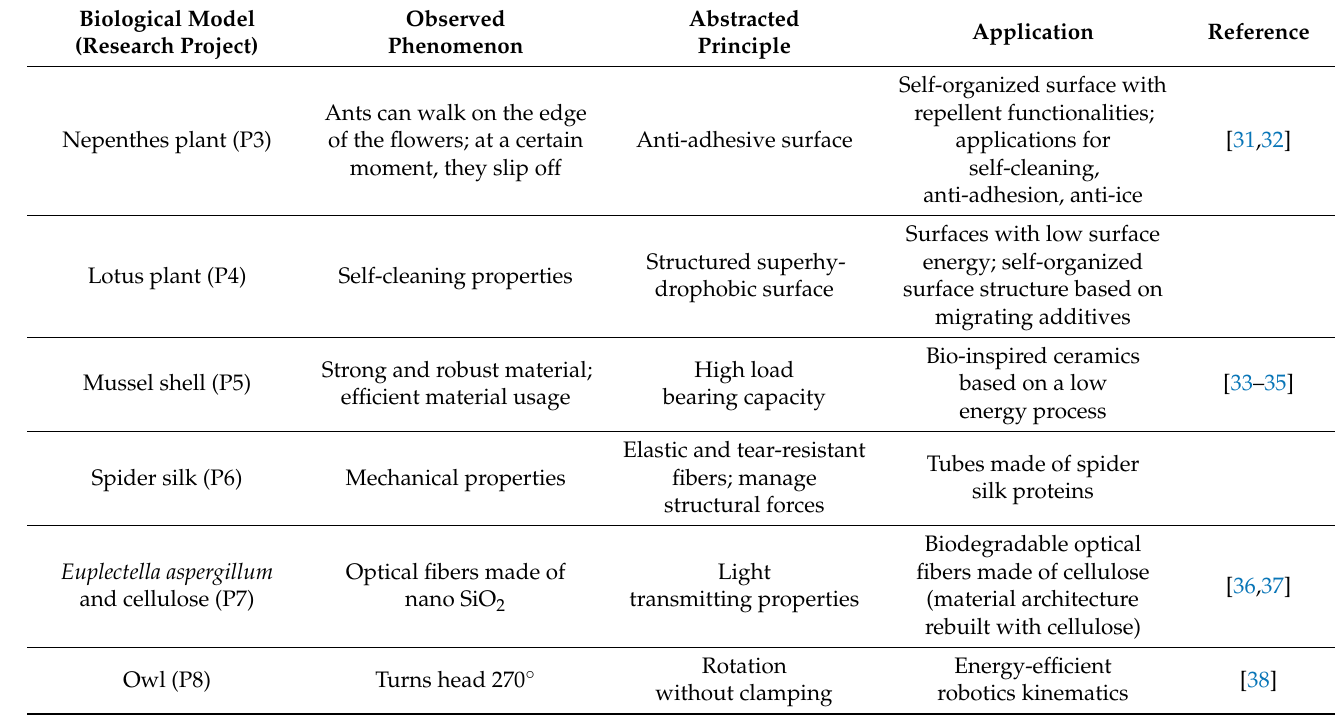
Table 2. Biological models and their abstracted principles for research